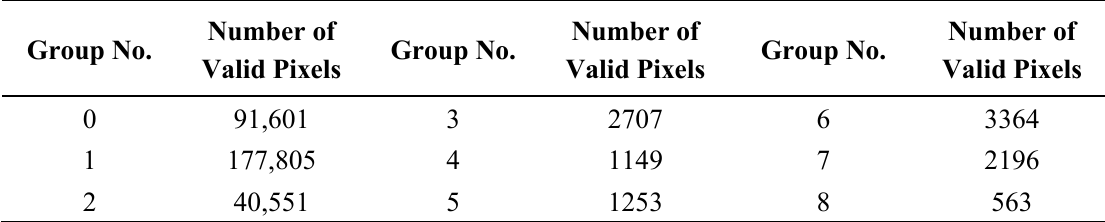
Figure 7. ( a ) The distribution of subsidence rates at all the valid pixels; and ( b ) comparisons between subsidence rates derived from Group 0 and Groups 0–8 in four areas labeled by S